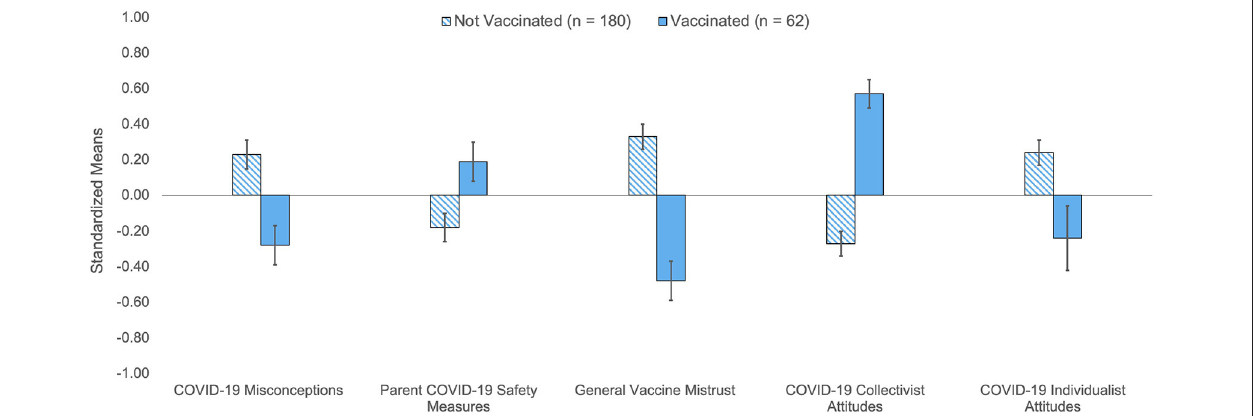
FIGURE 1 | Differences in standardized scale means for COVID-19 attitudes and beliefs by vaccination status among adolescents ages 12–17. Standardized means based on z-scores for COVID-19 attitudes and vaccine beliefs indicate that parents whose older adolescent child ages 12–17 years old was unvaccinated reported above average COVID-19 misconceptions, general vaccine mistrust, and COVID-19 individualist attitudes where parent COVID-19 safety measures and COVID-19 collectivist attitudes were below average. The opposite was true for parents whose child was vaccinated on all scales. Errors bars represent standard error means and 0 in the y-axis denotes the mean score. Independent t -tests indicated that both groups were significantly different from each other on all scales, p ≤ 0.001 to p =